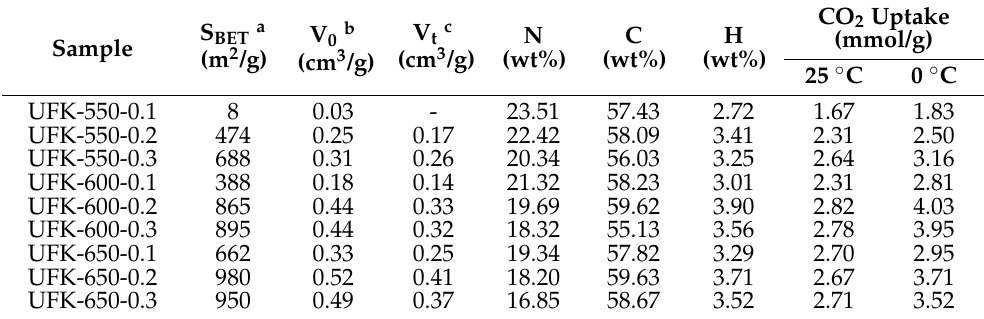
Table 1. Porous textural, elemental compositions, and CO 2 uptakes of adsorbents derived from Urea formaldehyde resin under different conditions.